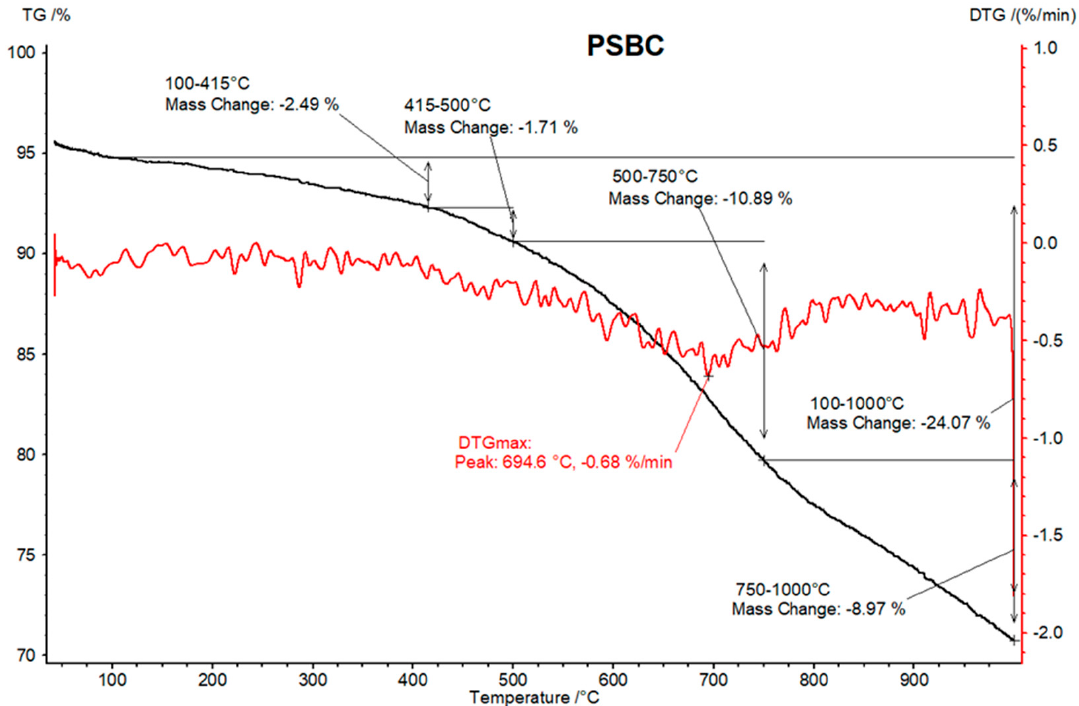
Figure A7. TG/DTG curves obtained for pine sawdust Figure A7 . TG/DTG curves obtained for pine sawdust biochar.